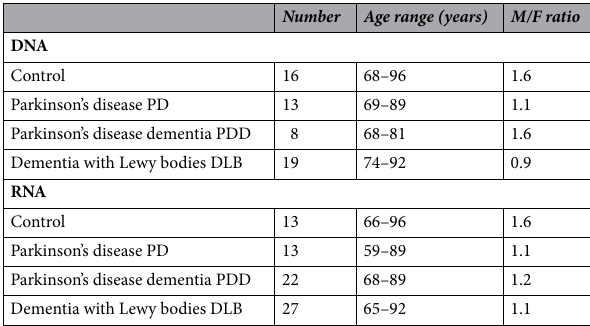
used including 13 PD patients, 8 PDD patients, 19 DLB patients and 16 healthy controls (for demographic char- acteristics of donors, see Table 2). Telomere and mitochondrial copy number assay.